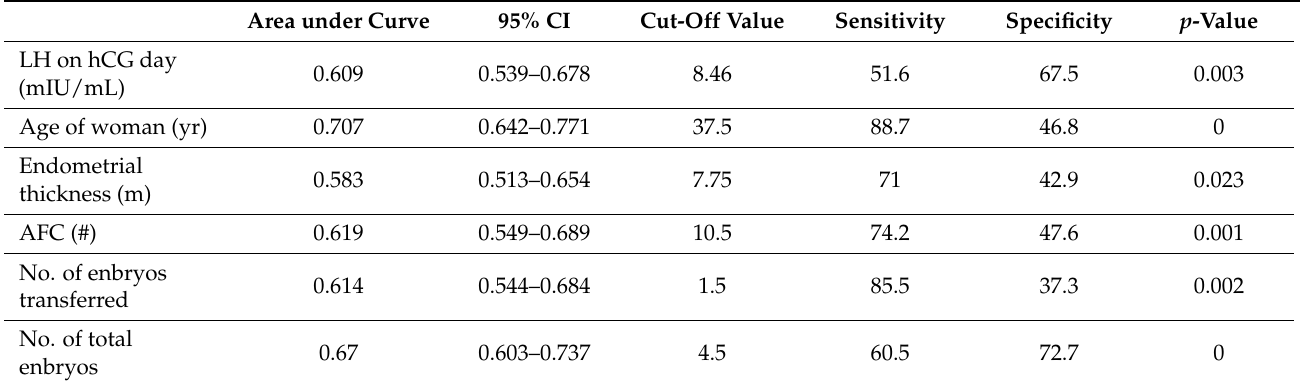
Table 4. Area under curve of ROC analysis and specific cut-off values for prediction of live birth. Area under Curve